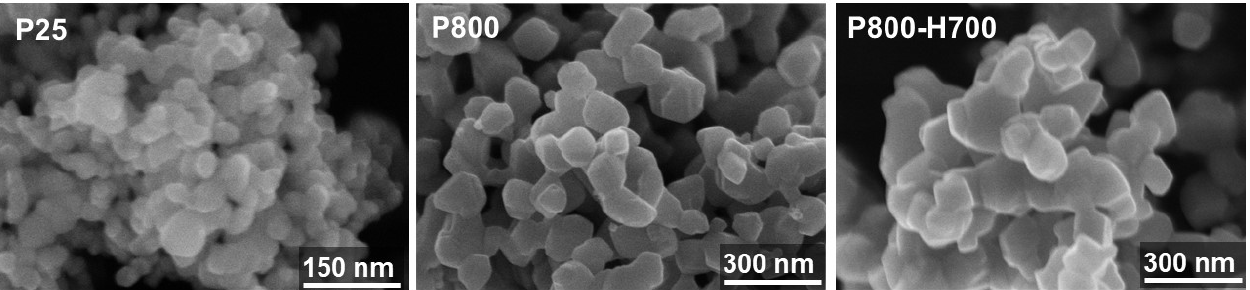
Figure 2. FE-SEM images of TiO 2 particles (P 25, P800, and P800-H700).